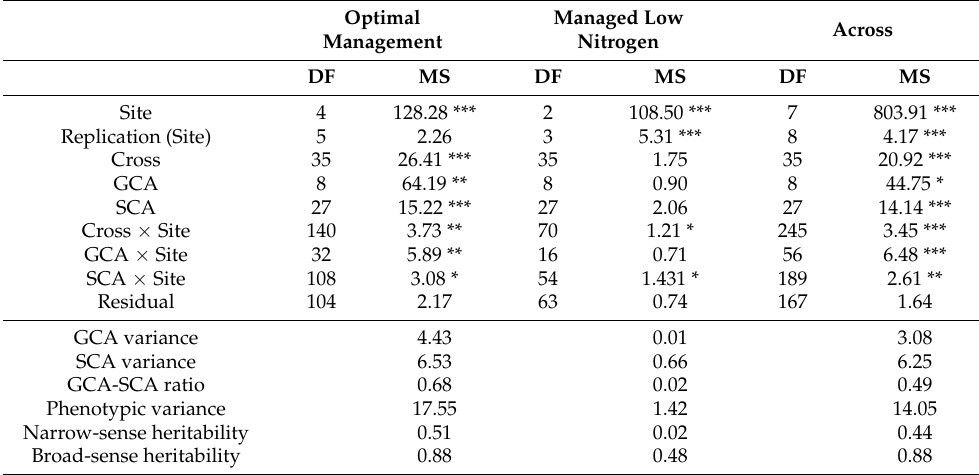
Table 3. Analysis of variance for grain-yield performance of half diallel crosses evaluated during the 2018 and 2019 summer seasons in Zimbabwe and Zambia. Optimal